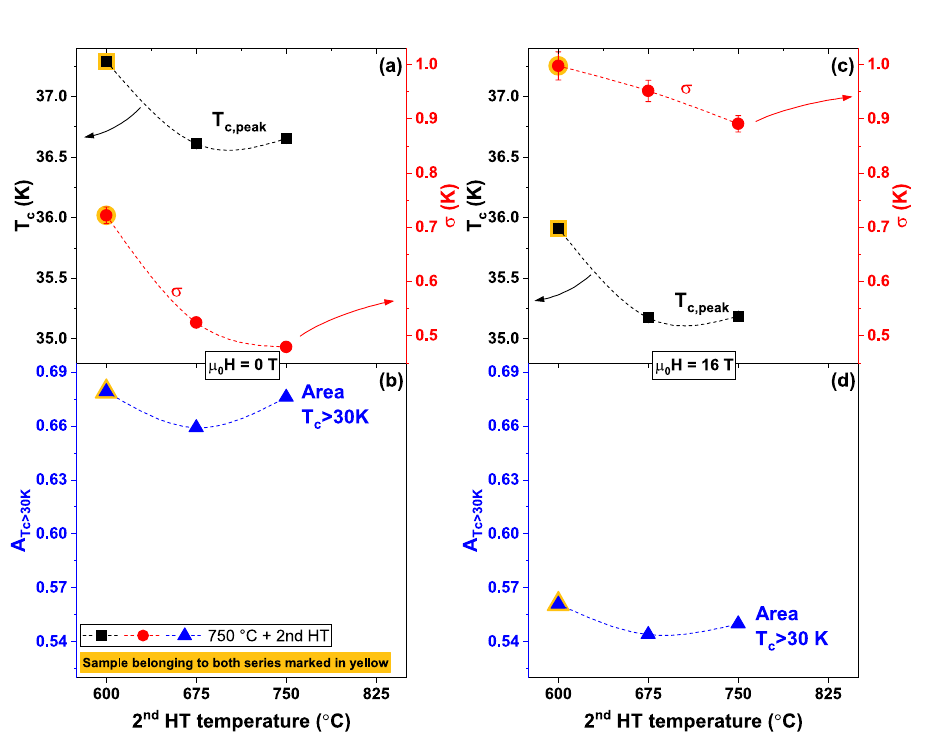
Figure 5. T c -distribution properties of the K-Ba122 samples as a function of the 2nd HT temperature. ( a ) position and width of the main peaks in the T c -distributions at 0 T obtained in Fig. 2. ( b ) area of the 0 T T c - distribution above 30 K. ( c , d ) similar data for the 16 T